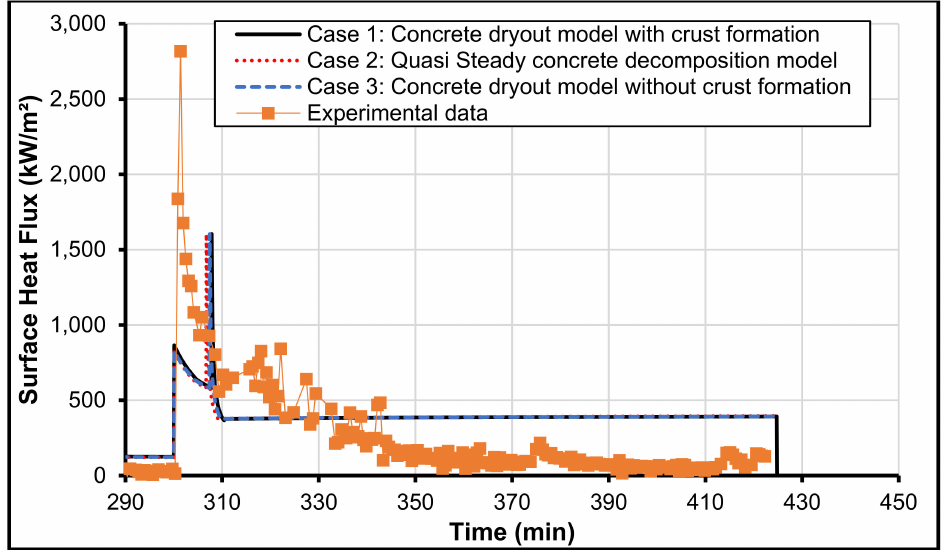
Figure 4. Comparison of CCI-2 experimental surface heat flux data with the developed model after injection of water at 300